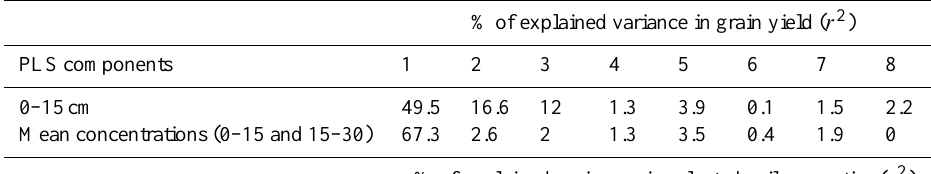
Table 3. Estimates of partial least-squares (PLS) percentage variances for soil parameters and maize grain yield for 0–15cm and mean concentration of soil properties from 0 to 15 and 15 to 30cm in a Ferralsol in Uganda.